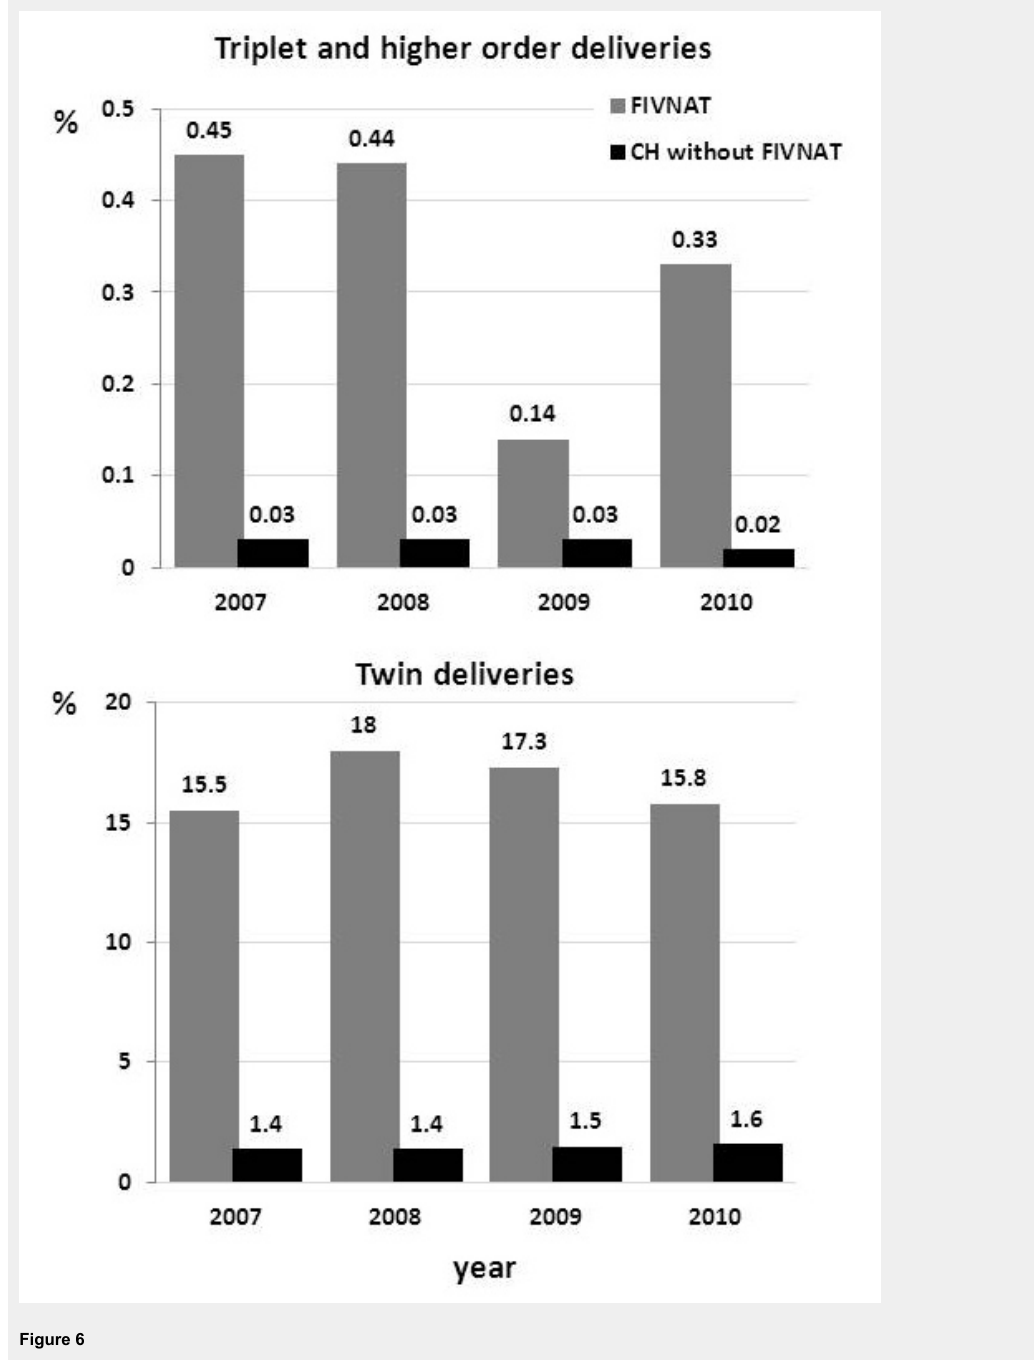
Both the incidence of twin deliveries (B) and of higher order deliveries (A) after assisted reproduction as recorded by FIVNAT (Source: ■■■?) far outnumber those among women conceiving naturally. A significant proportion of multiple pregnancies in Switzerland not registered by FIVNAT may be attributed to treatments with clomiphene citrate and ovulation induction followed by IUI or to treatment that was carried out in ART institutions outside